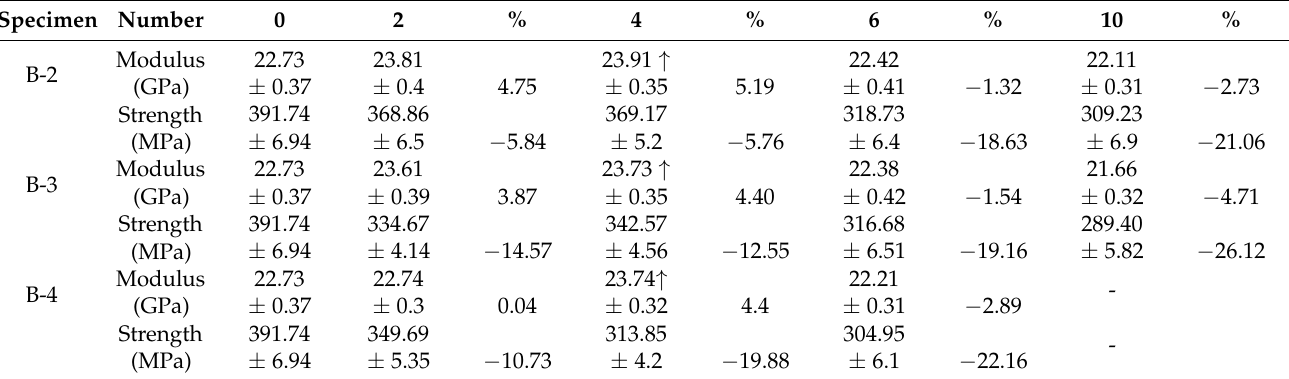
Figure 7. Comparison of the flexural stress-strain curves of different types of SMAHC laminates and GFRP. ( a ) Two wires, ( b ) four wires, ( c ) six wires, ( d ) ten wires. Table 4. Flexural properties of different types of SMAHC laminates.